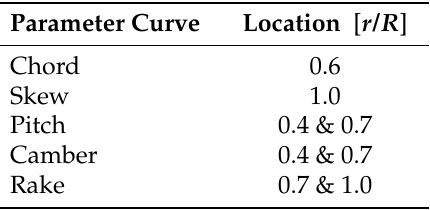
Table 12. Parameter setting for support optimisation